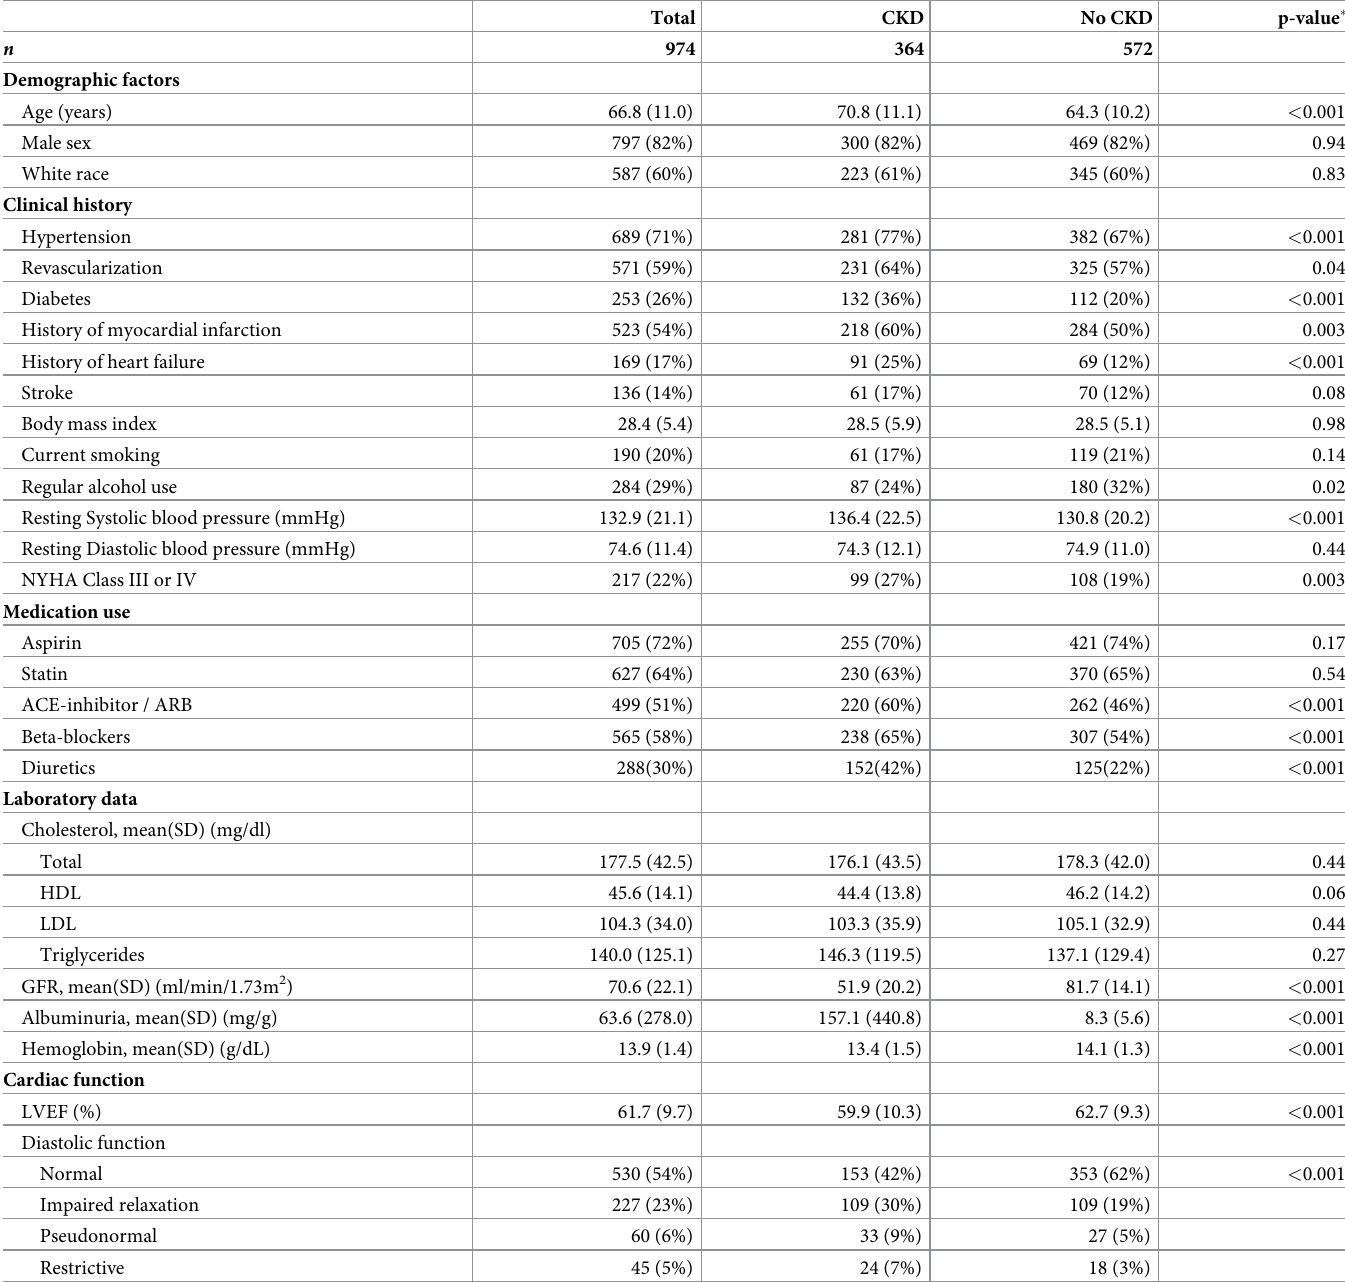
Table 1. Baseline patient characteristics in total sample and in sub-groups stratified on chronic kidney